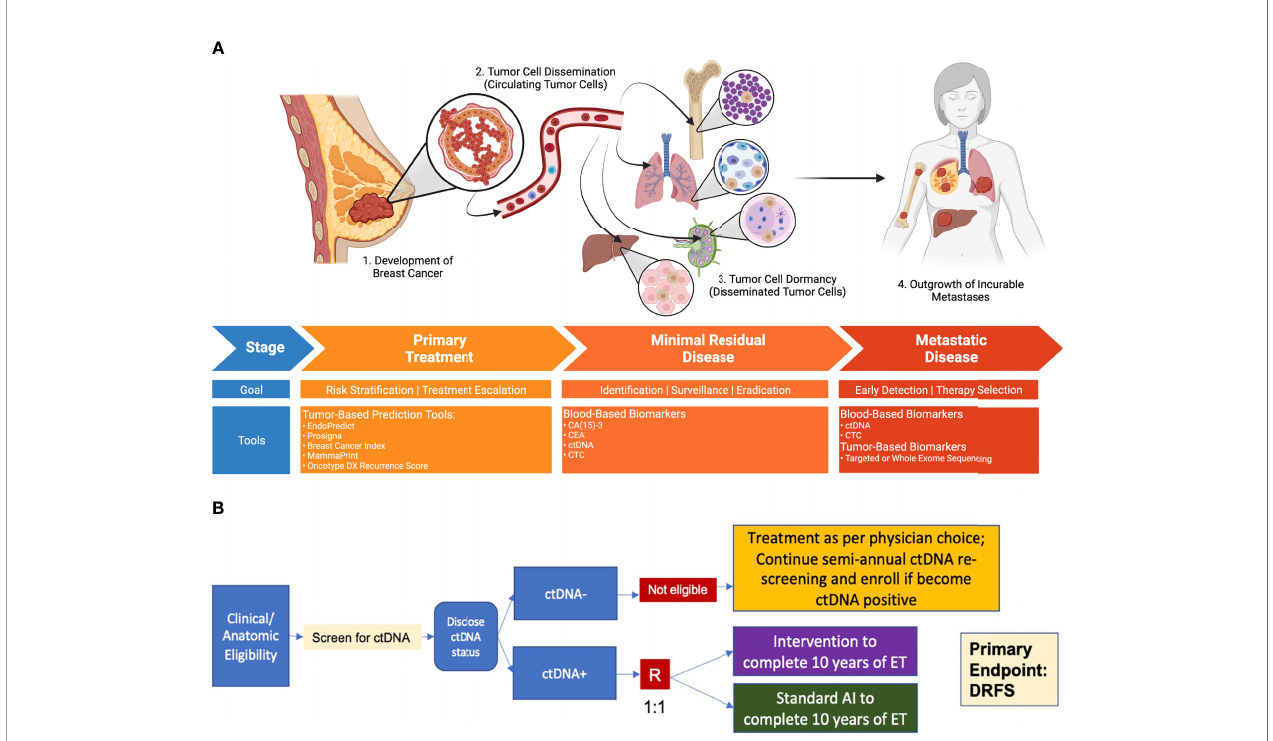
FIGURE 1 | Process by which primary tumors progress through dormancy to distant metastatic disease, and opportunities for intervention. (A) Breast Cancer Treatment Continuum: Minimal Residual Disease as a Therapeutic Opportunity to Prevent Late Recurrence. New approaches to identify at-risk individuals and evaluate therapies to reduce late recurrence may focus on the period following standard upfront treatment. The detection of minimal residual disease through blood- based surveillance tools might enable the identi fi cation of individuals at highest risk of metastatic recurrence, for whom escalated therapies may have the greatest potential bene fi t. The principal goal of such interventions is the prevention of metastatic recurrence. (B) Example Design Schema for a Phase 3 ctDNA-Guided Late Recurrence Trial. The use of highly sensitive ctDNA detection methods in patients at high clinical risk permits the identi fi cation of those most likely to recur, for whom investigational therapies could be evaluated (bottom). Those without detectable ctDNA may continue regular ctDNA surveillance, becoming eligible for therapeutic intervention if ctDNA is subsequently detected. Clinical endpoints of particular importance include distant recurrence-free survival, and overall survival. “ R ” denotes randomization step; DRFS, distant recurrence free survival; ET, endocrine